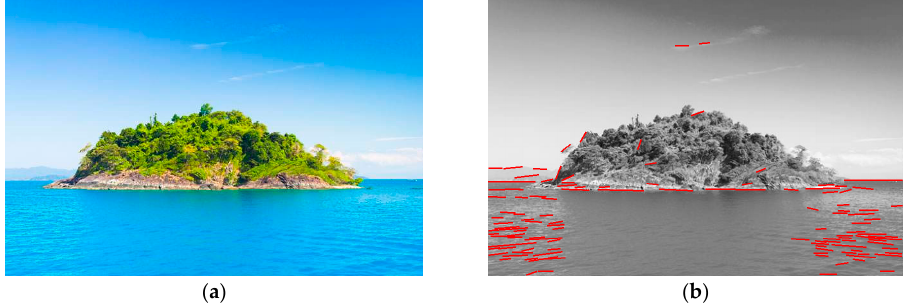
Figure 2. The direct application of the line segment detection (LSD) algorithm with false positive: ( a ) A given image with a small island, clouds and waves; ( b ) Line segments of the island, the clouds and the waves in the image also are extracted by the LSD algorithm, causing a false positive.